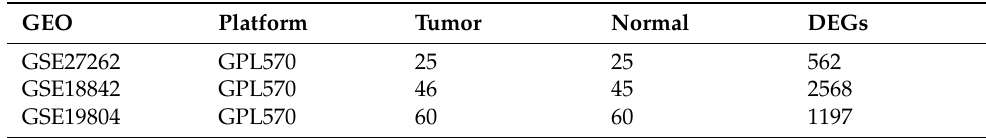
Table 1. The GEO gene expression datasets description.